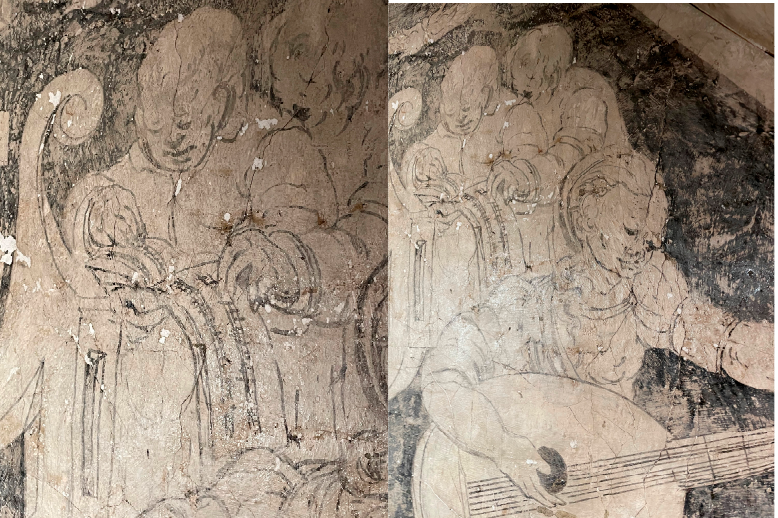
Figure 4. Detail of singing children and woman playing the lute, from the wallpainting from 34 Upper High Street, Thame.